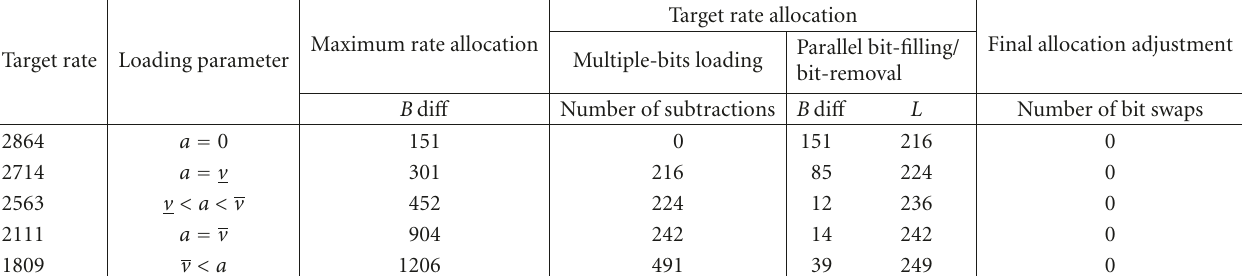
Table 1: Simulation results for ADSL loop T1.601#9 showing di ff erent allocation phases of the proposed algorithm. Maximum rate allocation Target rate Loading parameter